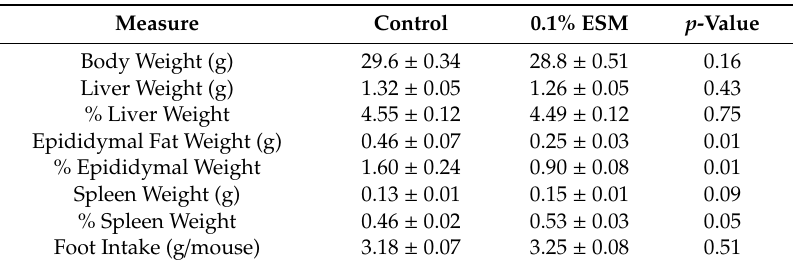
Table 1. Weights and Food